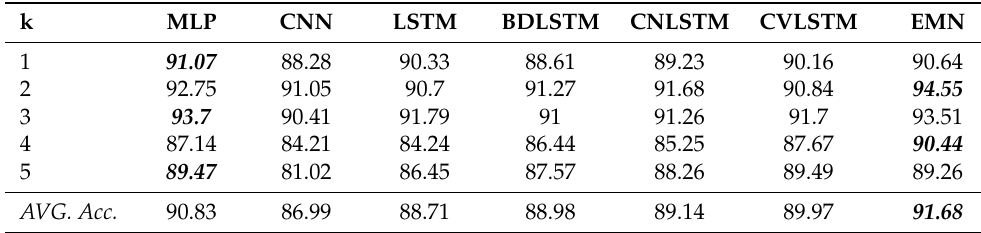
Table 1. The average classification accuracy (in %) for the eight postures and for the seven DL models as obtained by means of the 5-fold cross validation. The highest accuracy values are shown in bold slanted